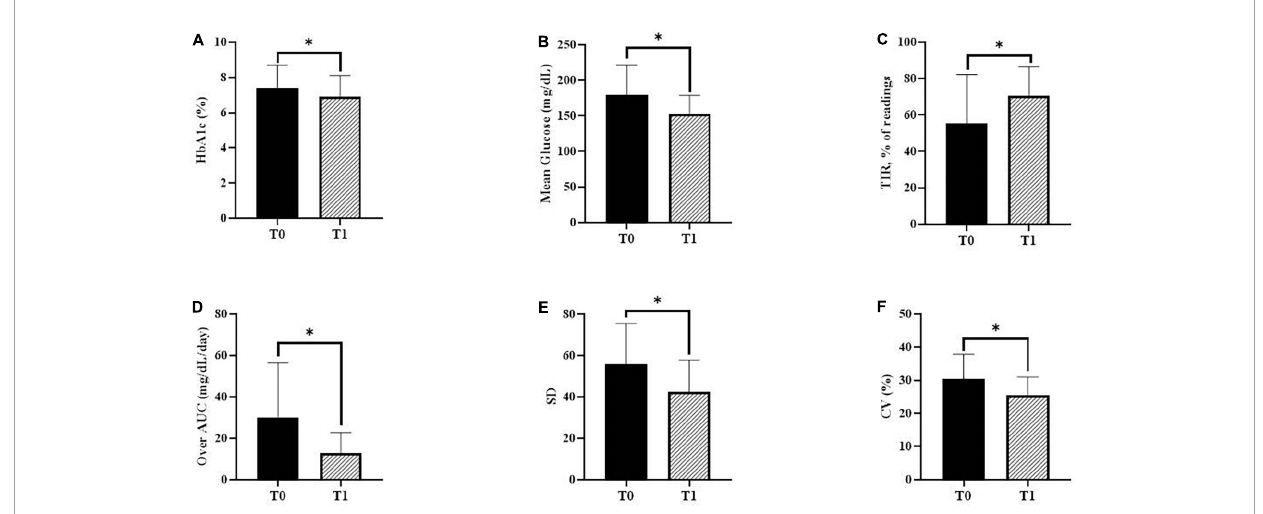
FIGURE2 Changes in glycemic markers and continuous glucose monitoring (CGM) metrics. (A) Glycated hemoglobin A1c (HbA1c) during baseline (T0) and follow-up (T1) ( P = 0.023). (B) The mean glucose levels using CGM during T0 and T1 ( P = 0.001). (C) The mean percentage of readings within time in range (TIR) during T0 and T1 ( P < 0.001). (D) The over-area under the curve (AUC) during T0 and T1 ( P = 0.001). (E) The standard deviation (SD) during T0 and T1 ( P = 0.001). (F) Percentage coefficient of variation (%CV) during T0 and T1 ( P < 0.001). P -values were calculated using the paired